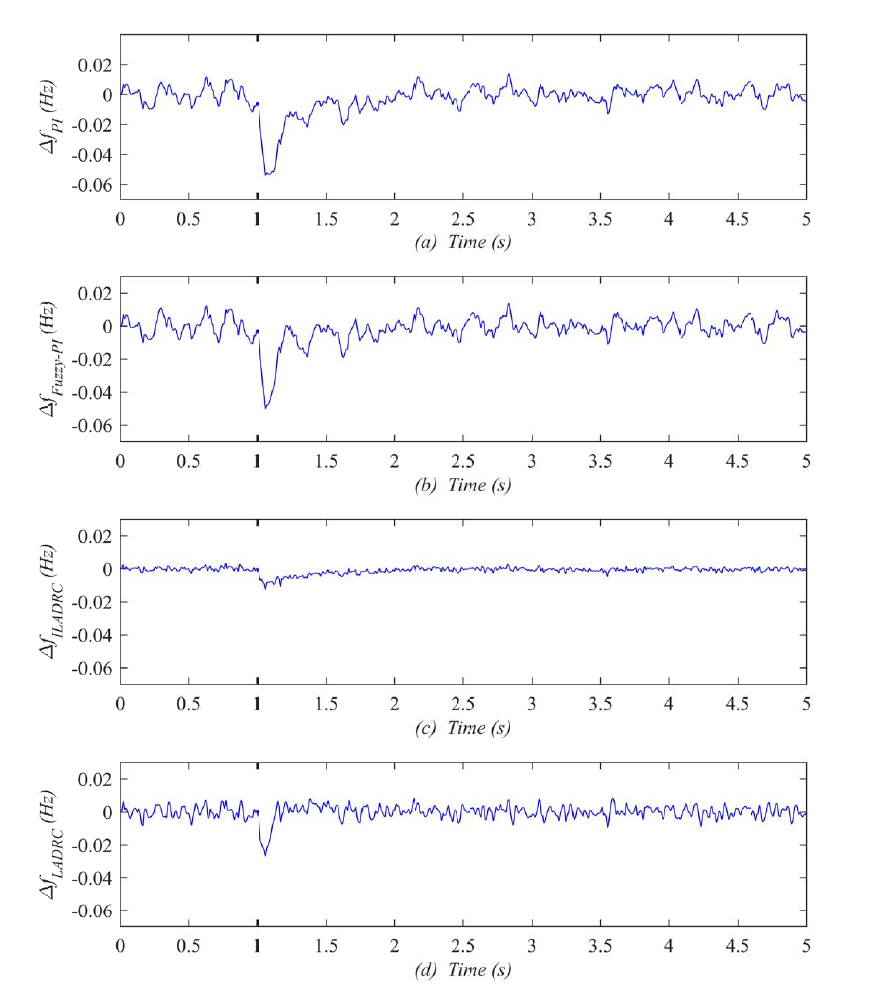
Figure 20. Transient response of system frequency deviation under stochastic power of wind turbine generator and +0.2 p.u. change of load demand. ( a ) Frequency deviation with PI controller; ( b ) Frequency deviation with Fuzzy-PI controller; ( c ) Frequency deviation with ILADRC controller; ( d ) Frequency deviation with LADRC